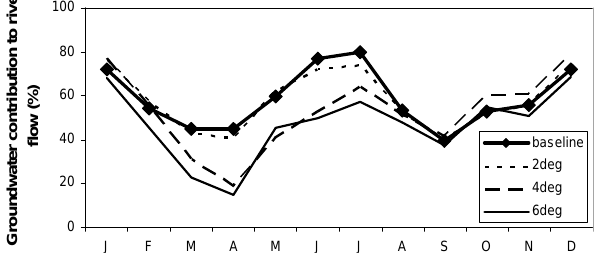
Fig. 5. Changes in the contribution of groundwater flow to the River Mitano under HadCM3 prescribed warming scenarios.